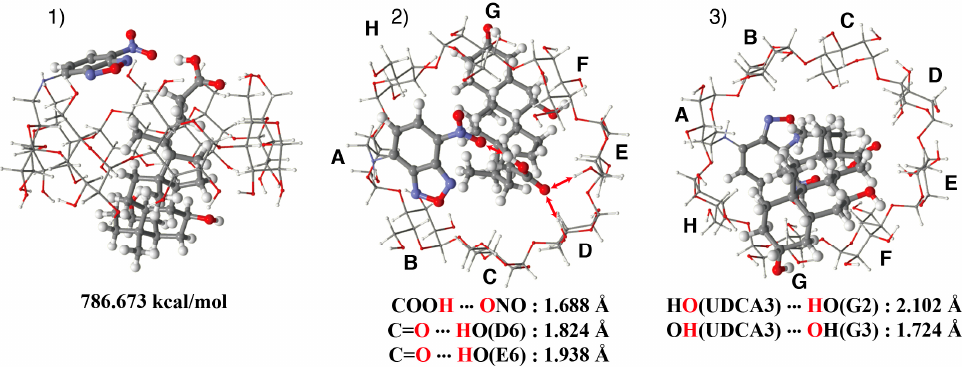
Figure 12. Estimated structure of the NC0 γ CD / UDCA complex ( 1 ) side view, ( 2 ) view from the primary hydroxy side, and ( 3 ) view from the secondary hydroxy side.